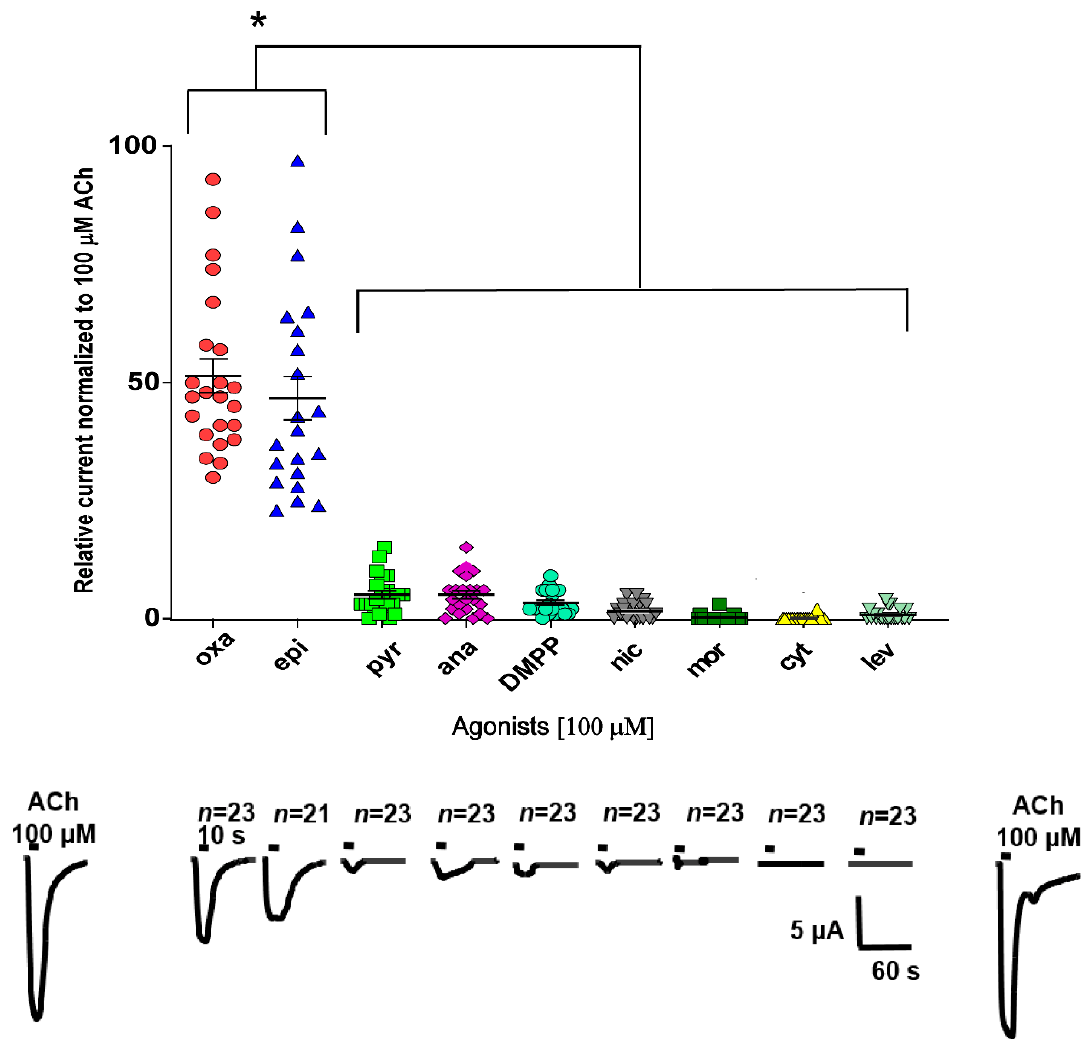
Figure 2. Effect of anthelmintics and cholinergic agonists on the Tmu -ACR-16-like receptor. A scatter dot plot (mean ± SEM) and representative sample traces show the rank order efficacy in μ A of four cholinergic anthelmintics: oxantel (oxa), pyrantel (pyr), morantel (mor), levamisole (lev) and five nicotinic agonists: epibatidine (epi), anabasine (ana), dimethyl phenyl piperazine (DMPP), nicotine (nic) and cytosine (cyt). * p < 0.02. The number of oocytes ( n ) used for each agonist is given above the traces, the perfusion time of each compound was 10 s as indicated with short bars above the traces.